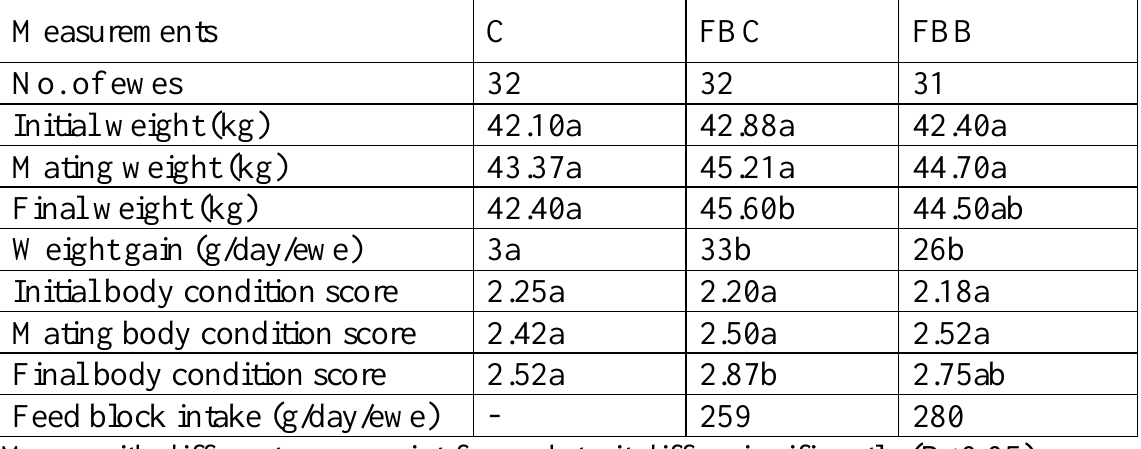
Table 3: Effect of feed block supplementation on weight, weight changes and body condition score of Awassi ewes grazing cereal